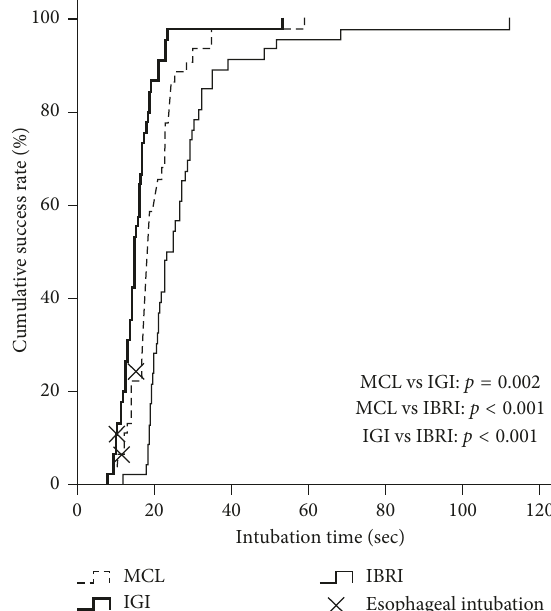
Figure 2: Comparisons of cumulative success rate among three intubation techniques regardless of kinds of endotracheal tubes.